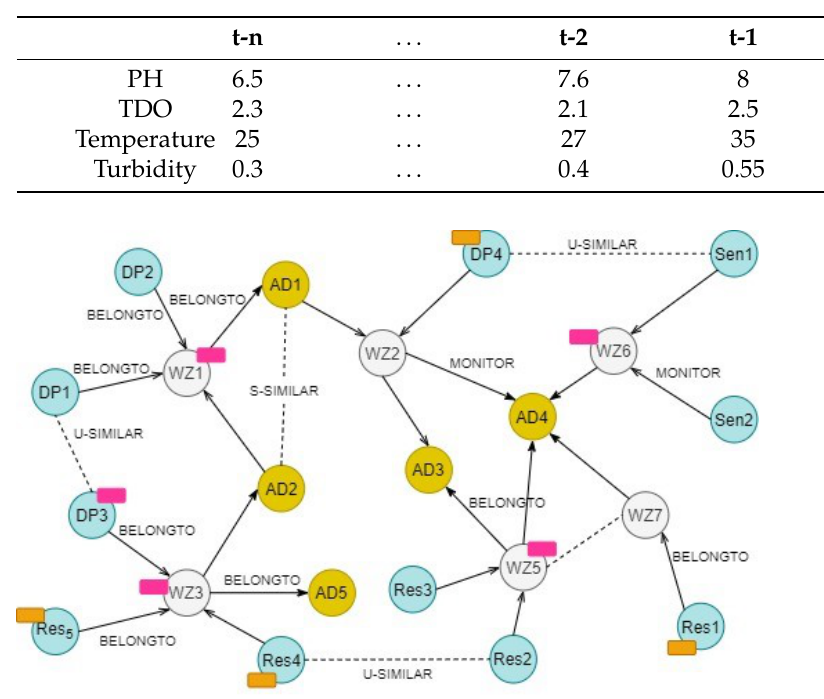
Table 3. Example of water monitoring matrix.